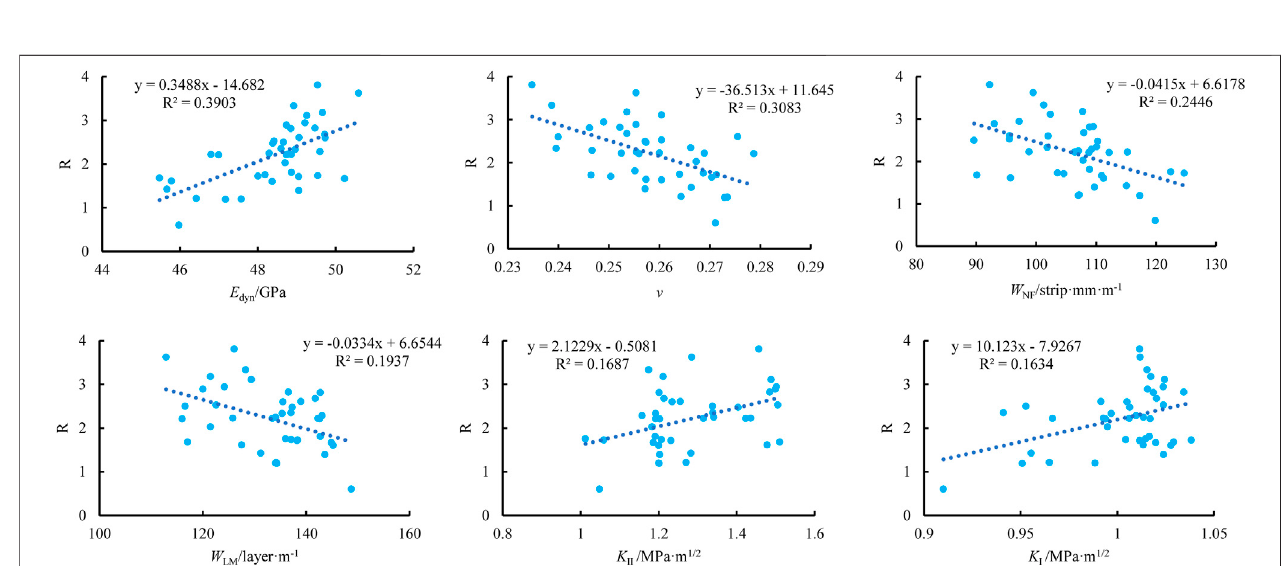
FIGURE 3 | The relationship between single-stage R of H6 platform and strong correlation factors.